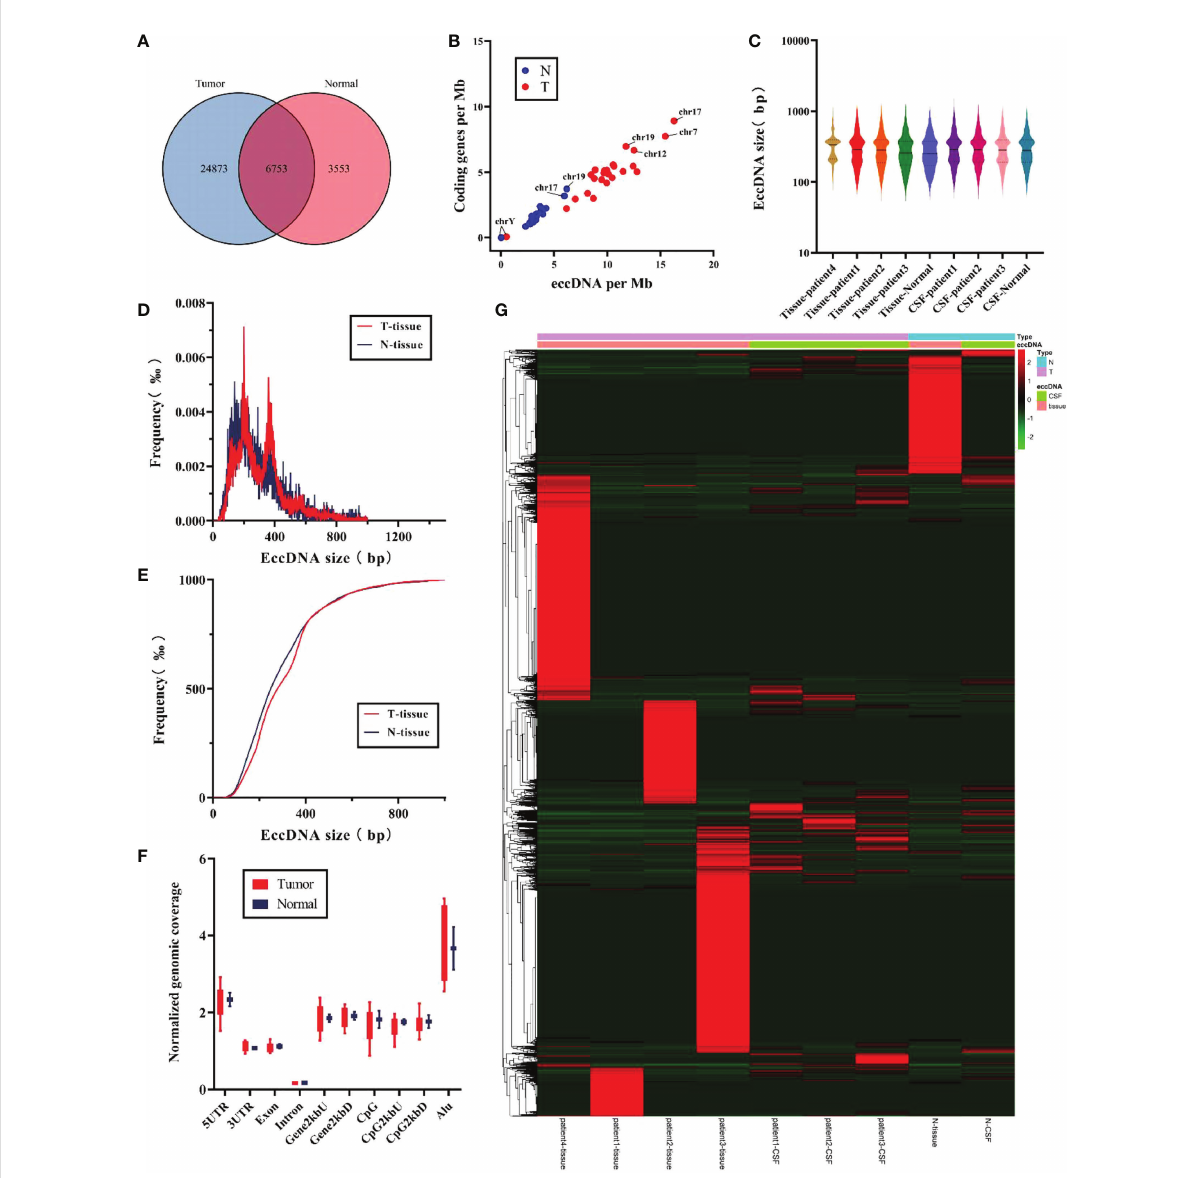
FIGURE 3 Comparison of the characteristics for eccDNAs in tumor samples and normal samples. (A) Differences in the counts for eccDNAs were detected in tumor and normal samples. (B) The ratio for coding genes/Mb and eccDNAs/Mb of chromosomes in tumor and normal samples. (C) Distribution of eccDNA length in each independent sample. (D, E) Size distribution of eccDNAs in tissue for tumor (red) and normal (blue). (F) Genomic distributions of eccDNAs between tumor (red) and normal (blue). (G) Heat map of abundance of eccDNAs in each